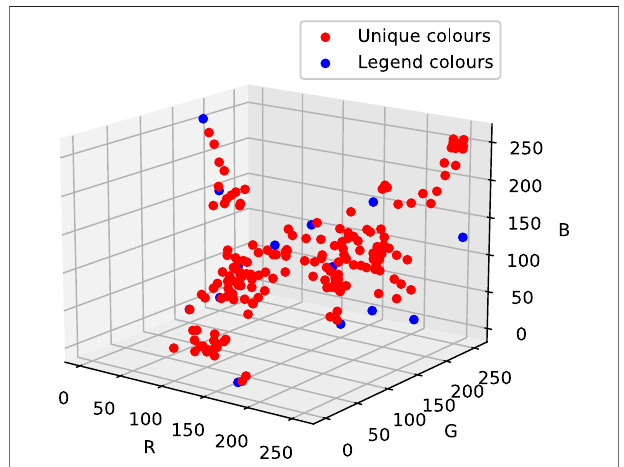
FIGURE 8 | Unique colours (red) vs listed colours in the legend